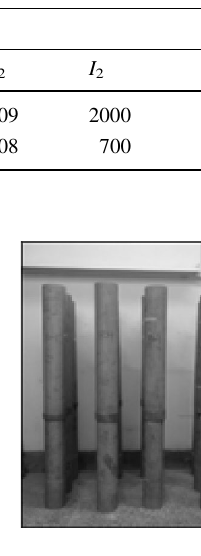
Fig. 4 Schematic of pier column Fig. 5 Lapped steel tube specimens